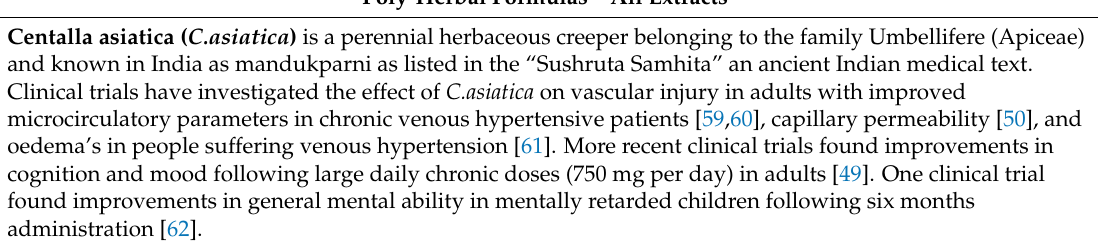
Table 5. History and description of each extract from poly-herbal formulas and their benefits on human health. Poly-Herbal Formulas—All